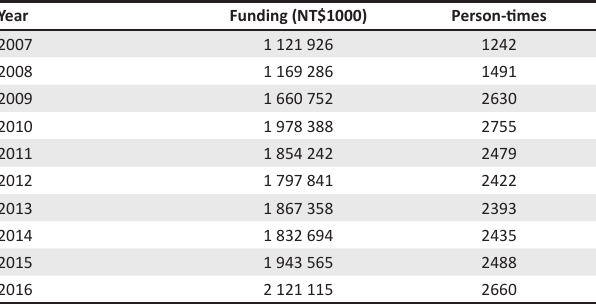
TABLE 1: Recruitment of science and technology personnel,